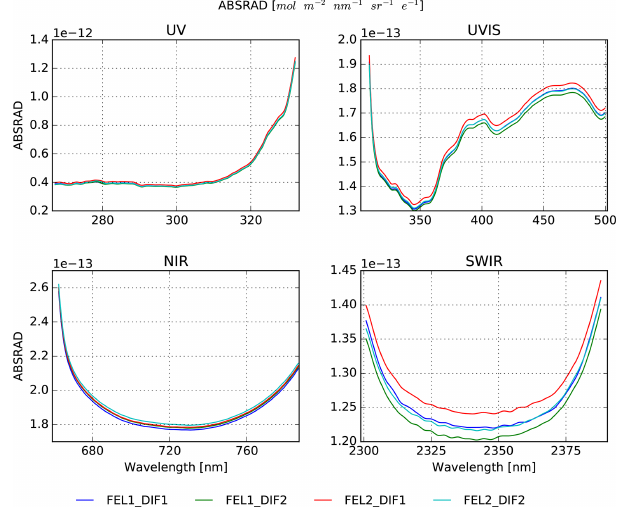
Figure 13. ABSRAD calibration for the optical axis row for all spectrometers. Shown are data for lamps FEL1 and FEL2 for both diffusers DIF1 and DIF2. For UVIS, stronger gradients are observed than for the other spectrometers. The calibration curves are the com- bination of response of the detectors and the wavelength-dependent optical throughput of the